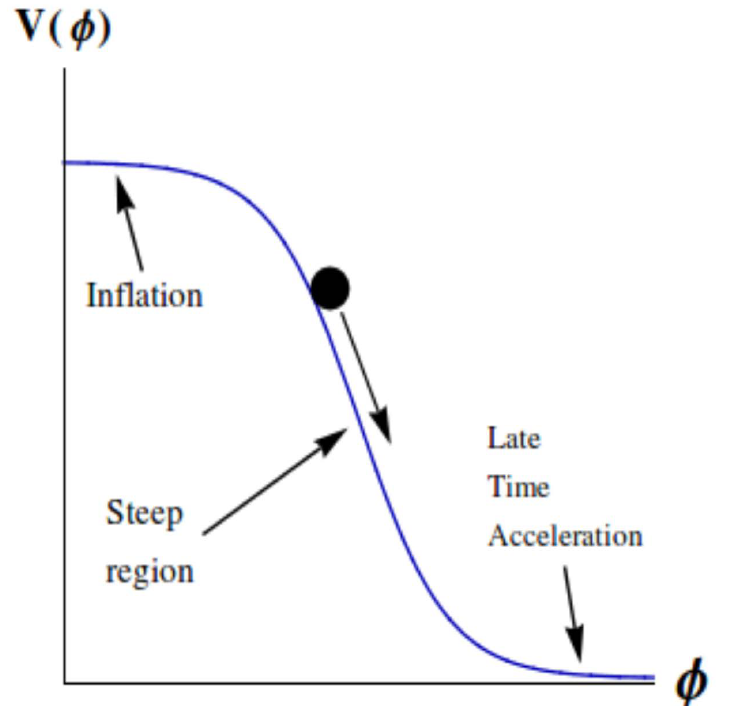
Figure 1. The figure displays a typical scalar field potential required to realise quintessential inflation: potential shallow initially, followed by steep behaviour thereafter, and shallow again around the present